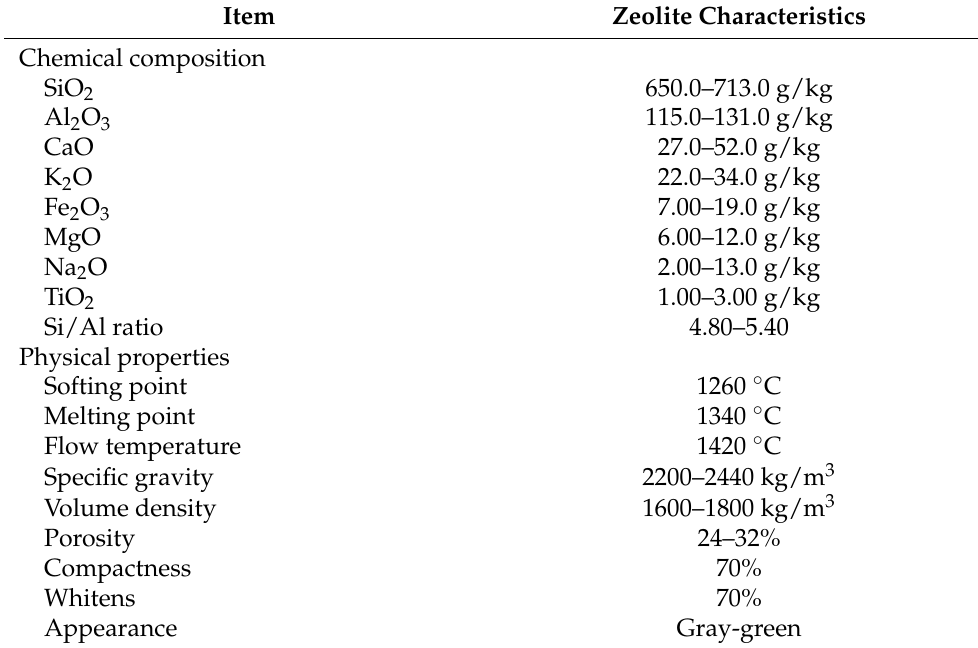
Table 1. Chemical composition and physical properties of the natural form of